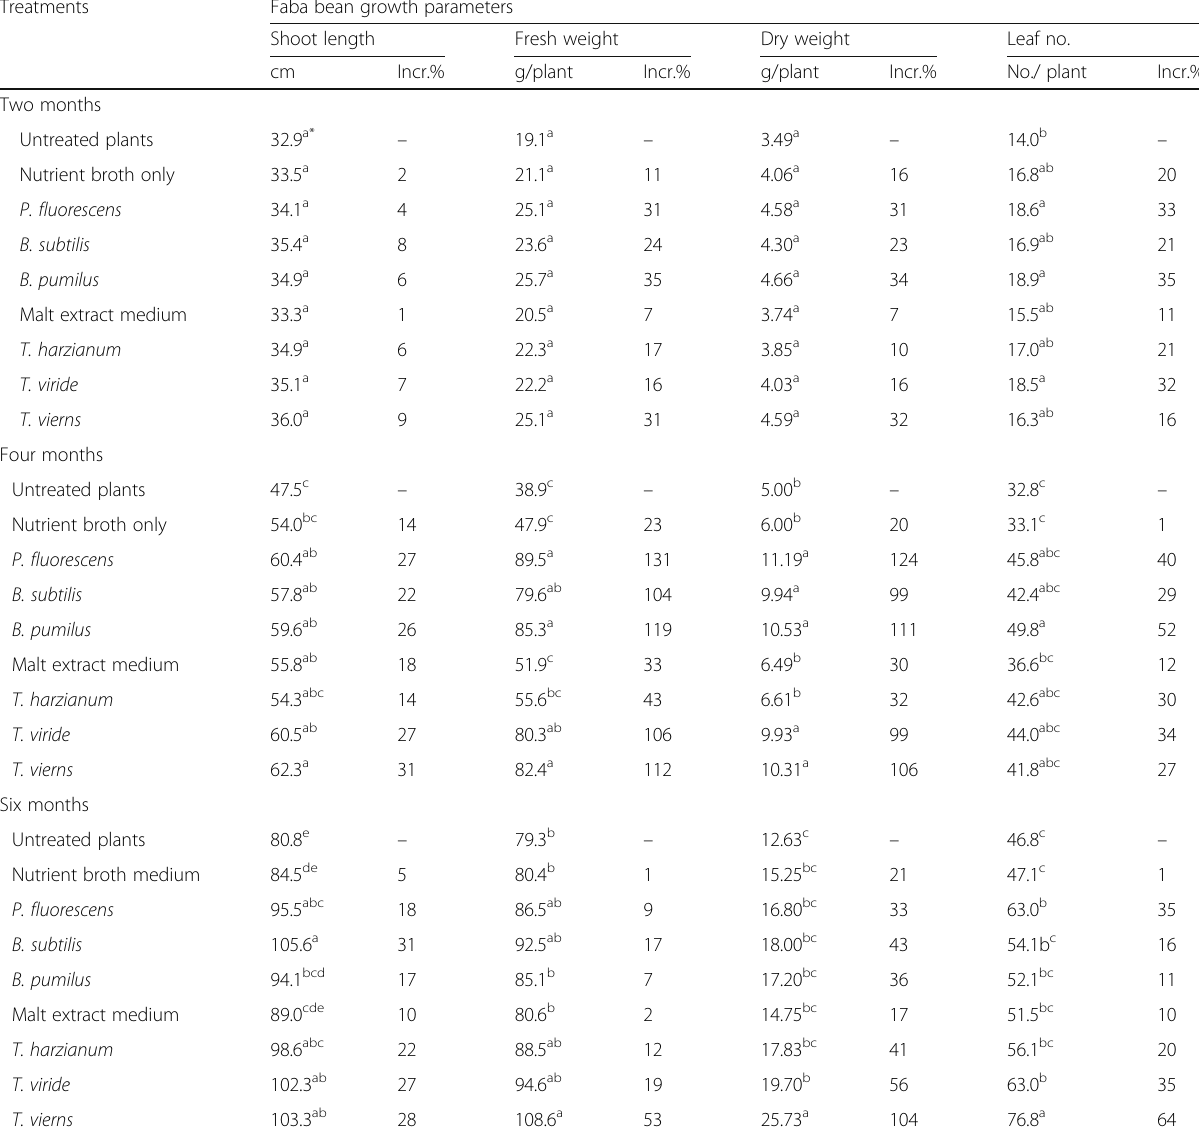
Table 1 Effects of plant growth-promoting bacteria and Trichoderma species on growth parameters of faba bean without Orobanche crenata treatment under greenhouse conditions (Experiment I)